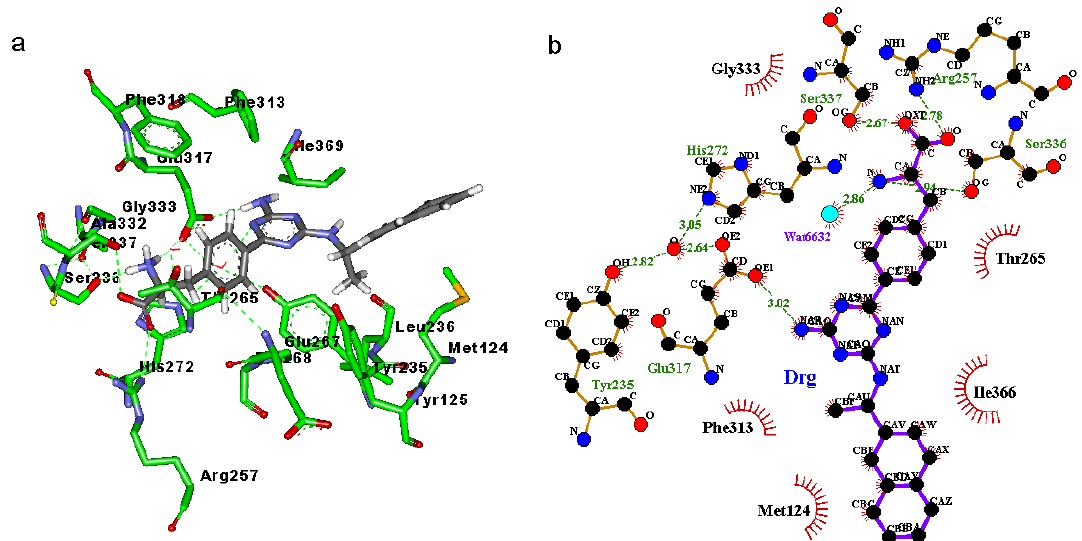
Figure 7. ( a ) Binding modes of inhibitor 1d with the key residues of TPH1 that are essential for the binding; ( b ) 2D contour of the binding modes generated by Ligplot plus.